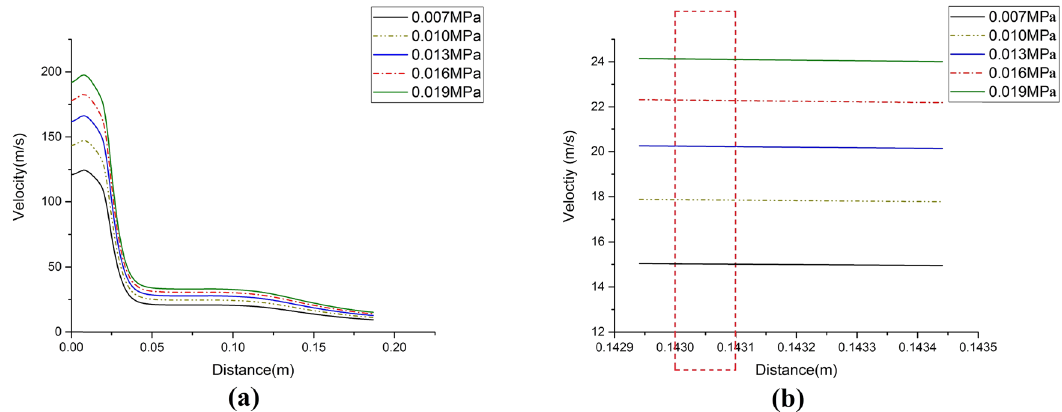
Figure 6: Centerline velocities under di ff erent air pressures: ( a ) research distance is [ 0, 0.187 m ] , ( b ) research distance is the e ff ective stretch